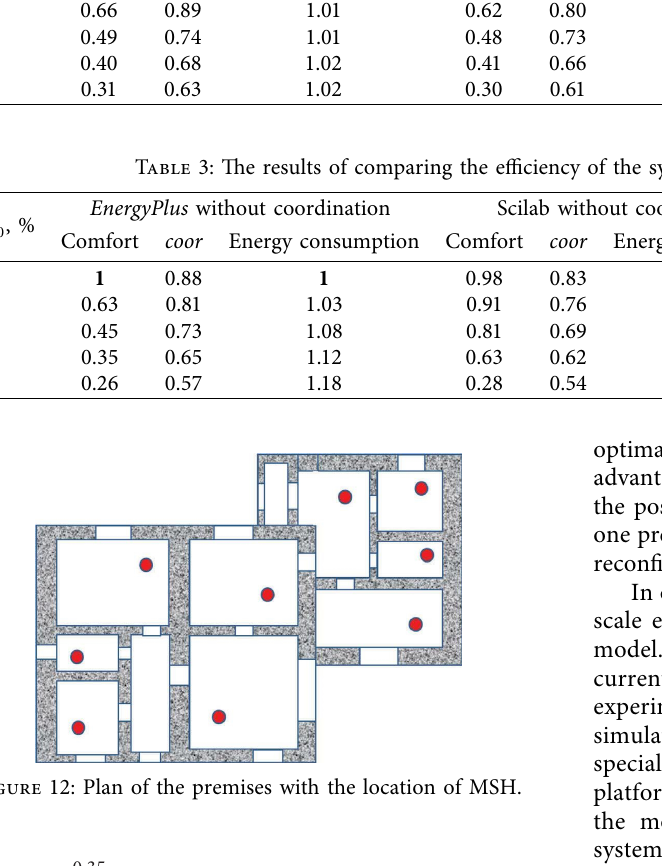
Table 2: Te results of comparing the efectiveness of the system with and without coordination under the infuence of external temperature and F � const σ u / F , % 0